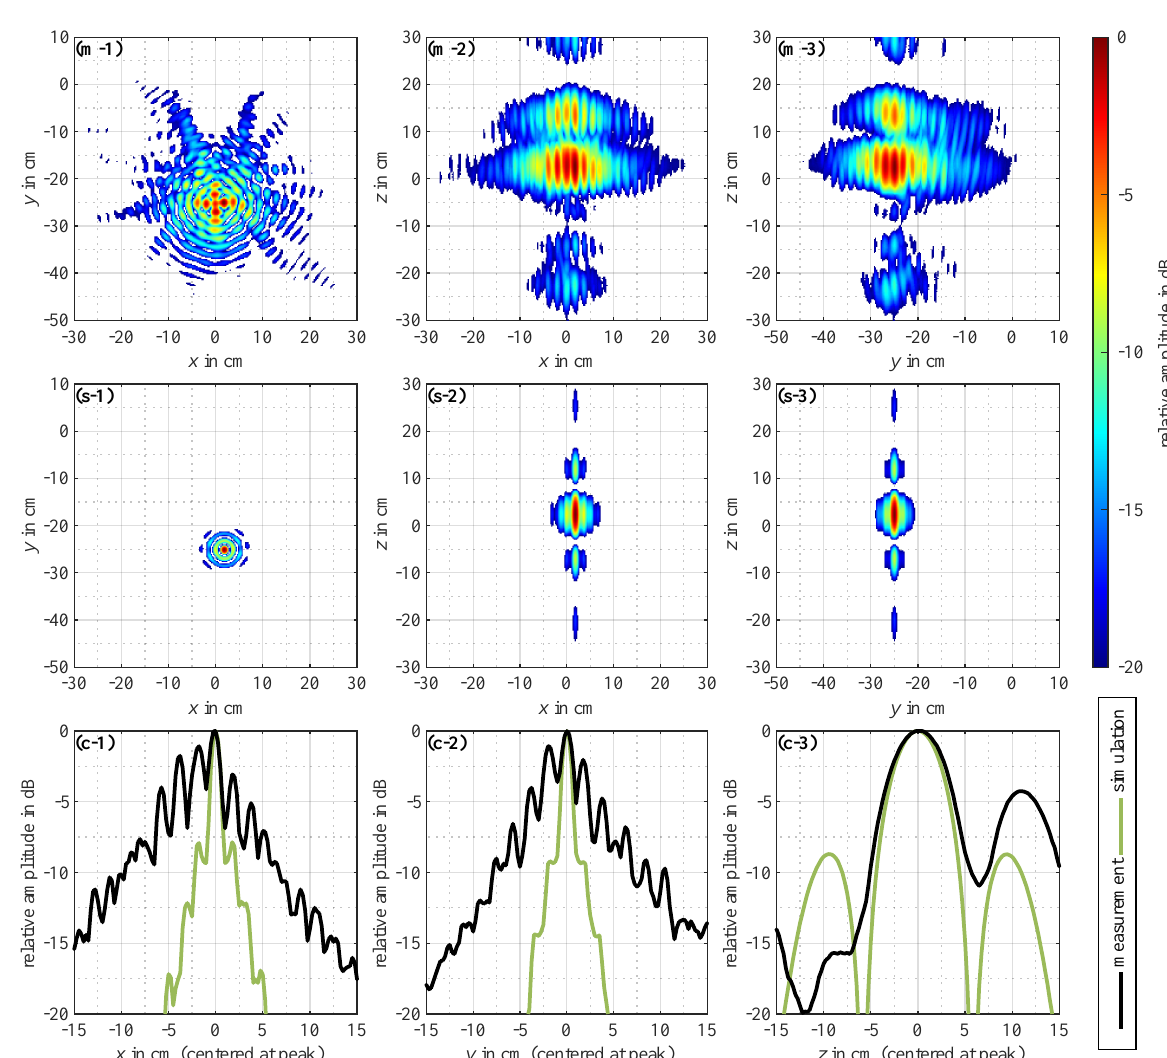
Figure 2. Comparison of ( m-1,2,3 ) experimentally obtained and ( s-1,2,3 ) synthetically generated images (our experimental data were previously published in [9]). The depictions ( m,s-1,2,3 ) are maximum projections of a three-dimensional Cartesian image volume. All images are in logarithmic scale and normalized to their respective maximum with a total dynamic range of 20dB. Values below − 20dB are set transparent. ( m,s-1 ) Images showing for each x , y coordinate the maximal value along the z direction. ( m,s-2 ) Images showing for each x , z coordinate the maximal value along the y direction, and ( m,s-3 ) images showing for each y , z coordinate the maximal value along the x direction. ( c-1,2,3 ) Maximum profiles of ( — ) experimentally obtained and ( — ) synthetically generated images. The Curves are centered at the x , y , z coordinates of the image maxima in ( m-1,2,3 ). For each coordinate, the maximum image value among the remaining two axes is